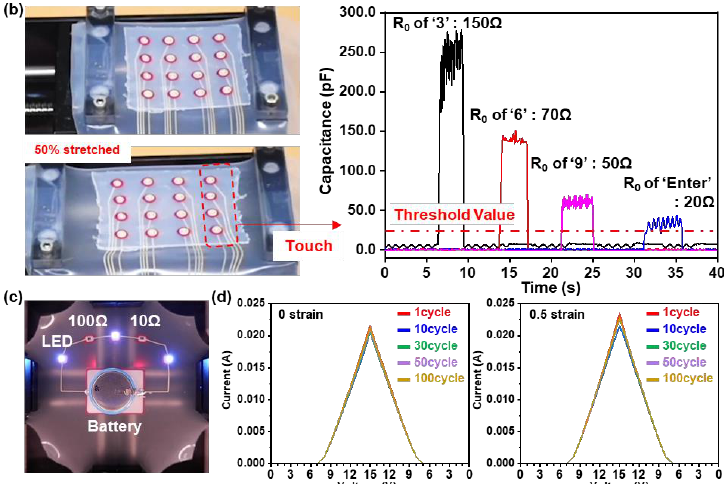
Figure 6. Stretchable keypad demonstration. ( a ) Photograph of the system. 4 × 4 array of touch sensors printed on the iPCB made with rigid–intermediate–soft ( RIS) materials and connected to an Arduino ( left ). Keypad configuration ( right top ) and a circuit diagram of the system ( right bottom ). ( b ) Optical image of 50% stretched stretchable keypad ( left ). Change in capacitance during touch of ‘ 3 ’, ‘ 6 ’, ‘ 9 ’ , and ‘Enter’ on the keypad ( right ). ( c ) Image of a stretchable iPCB with electrical components (chip LEDs, resistors, and battery). ( d ) Current output signals from the device at 0 and 0.5 strain.